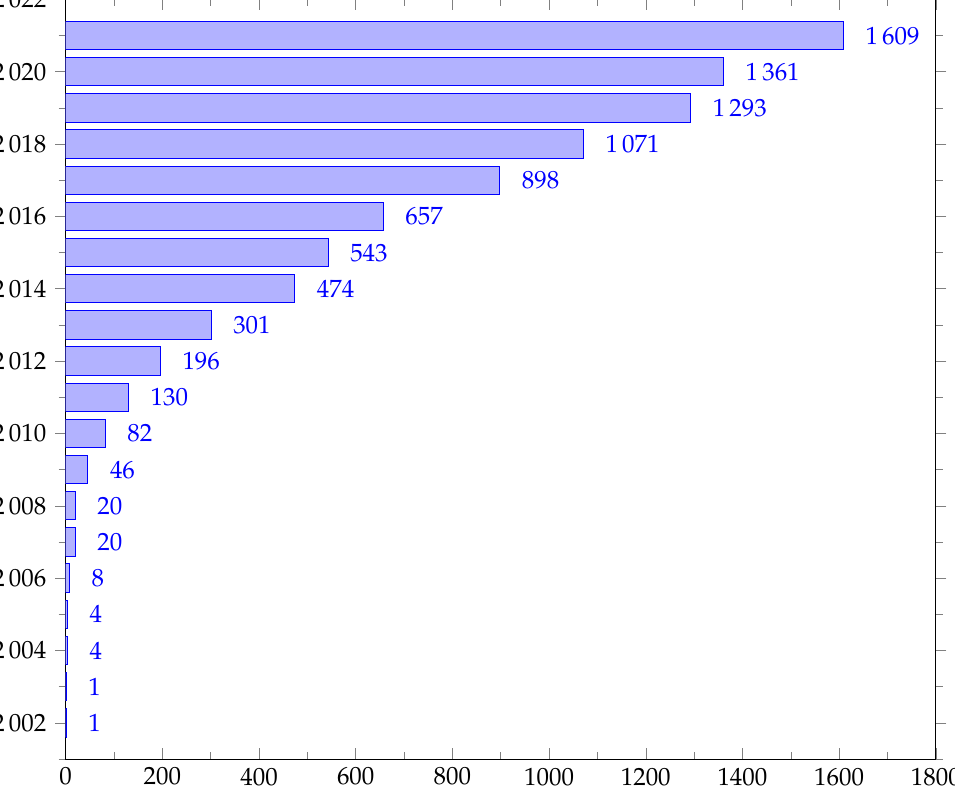
Figure 1. Number of research papers dealing with MG and NMG management published in peer- reviewed journals owned by the leading publishers of scientific content from 2002 to